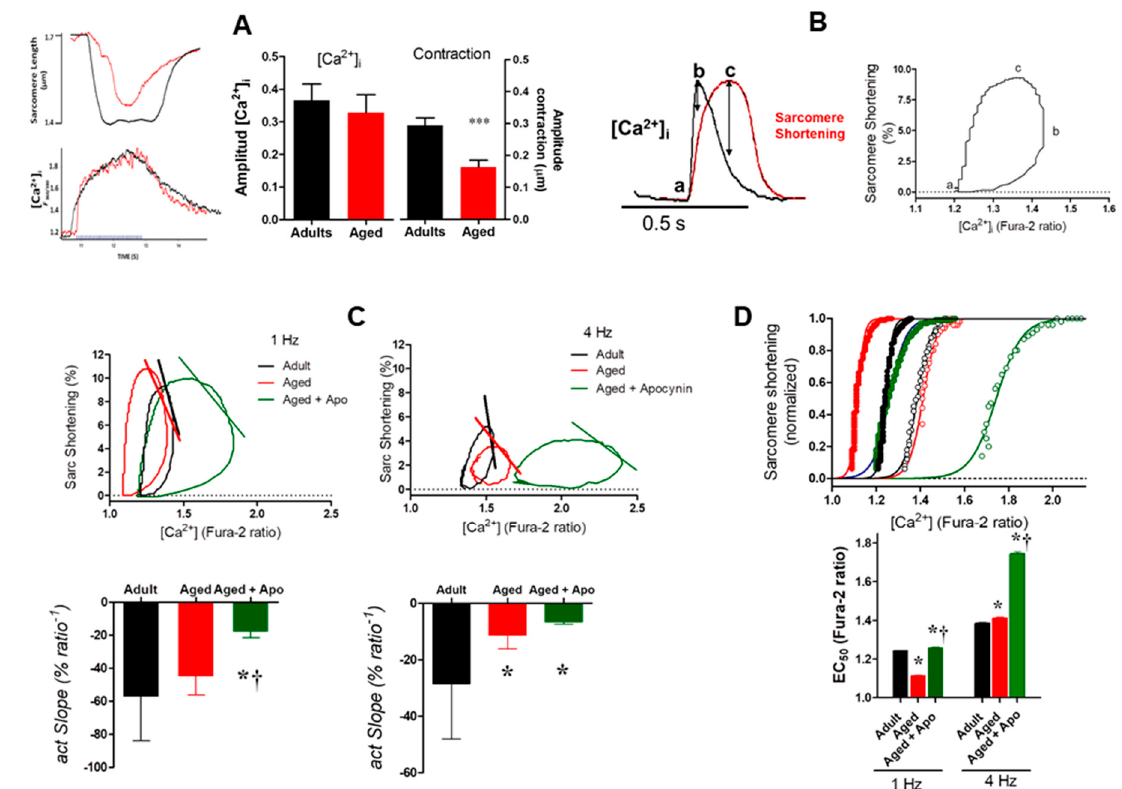
Figure 4. Myofilaments Sensitivity. ( A ) Using thapsigargin to block SERCA activity, myocytes were submitted to tetanic stimulation (40 Hz) to evaluate the myofilaments Ca 2+ sensitivity. (Left panels): contraction (up) and the [Ca 2+ ] i evoked by tetanic stimulation. (Right panels): pooled data for the amplitude of contraction (evaluated as degree of sarcomere shortening) and the amplitude of the cytosolic Ca 2+ concentration evoked by tetanic stimulus in adult and aged cardiomyocytes. *** p = 0.0002. N = 20 cells from adult ( n = 3) hearts and 29 cells from aged hearts ( n = 3). ( B ) Phase loop analysis for the sarcomere shortening-[Ca 2+ ] i relationship. Example of hysteresis analysis of Ca 2+ vs. sarcomere shortening for a normal twitch. The segment from a-b represents the Ca 2+ activating phase, the b–c segment represents cross-bridge feedback, and the a-c segment represents the relaxation phase. ( C ) Hysteresis loops used to obtain the slope of the activation phase at 1 and 4 Hz. ( D )